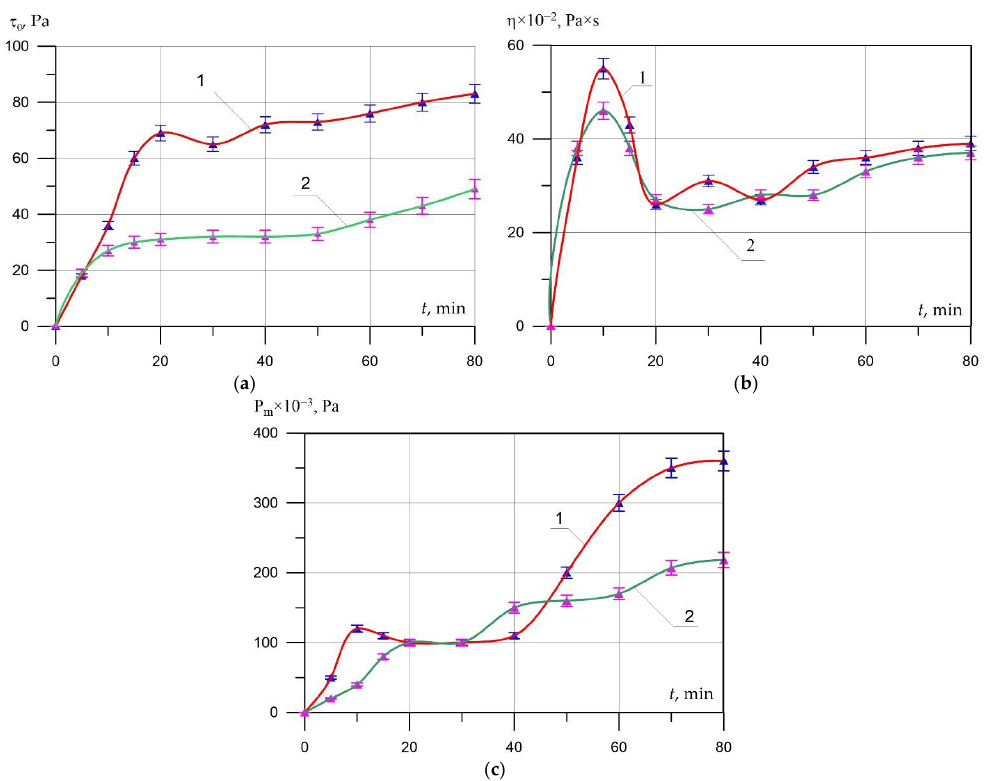
Figure 6. Influence of preliminary hydration of the binder on the rheological characteristics of the interpore material (1 — non-porous mixture of the control composition; 2 — non-porous mixture on pre-hydrated binder): ( a ) ultimate shear stress; ( b ) plastic viscosity; ( c ) plastic strength.